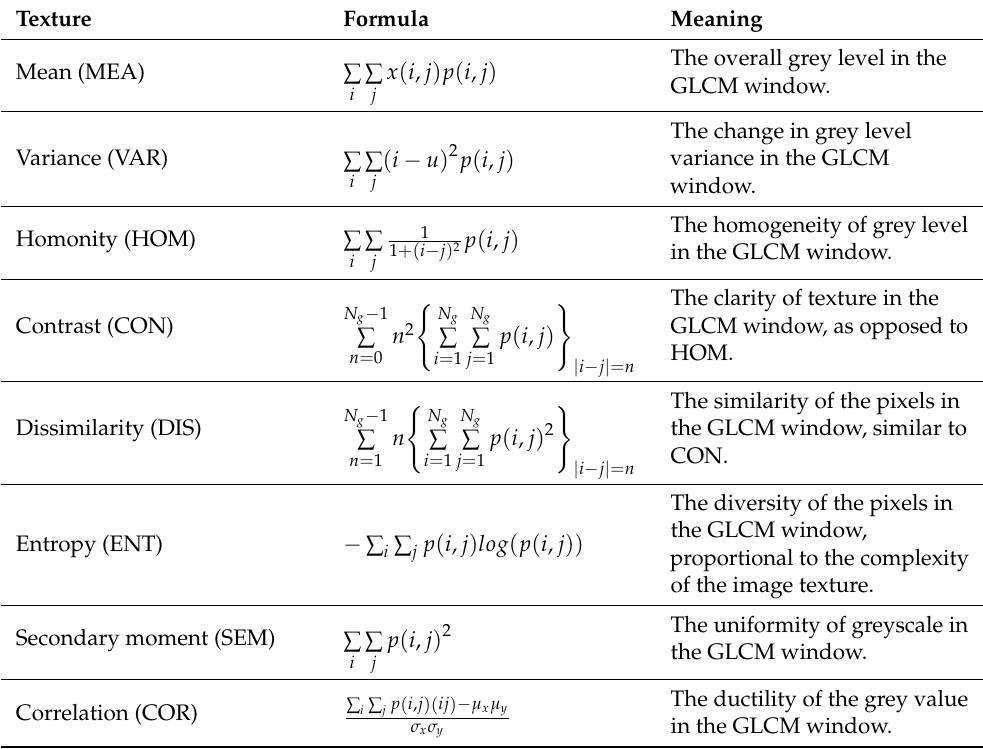
Table 2. Calculation formula of texture